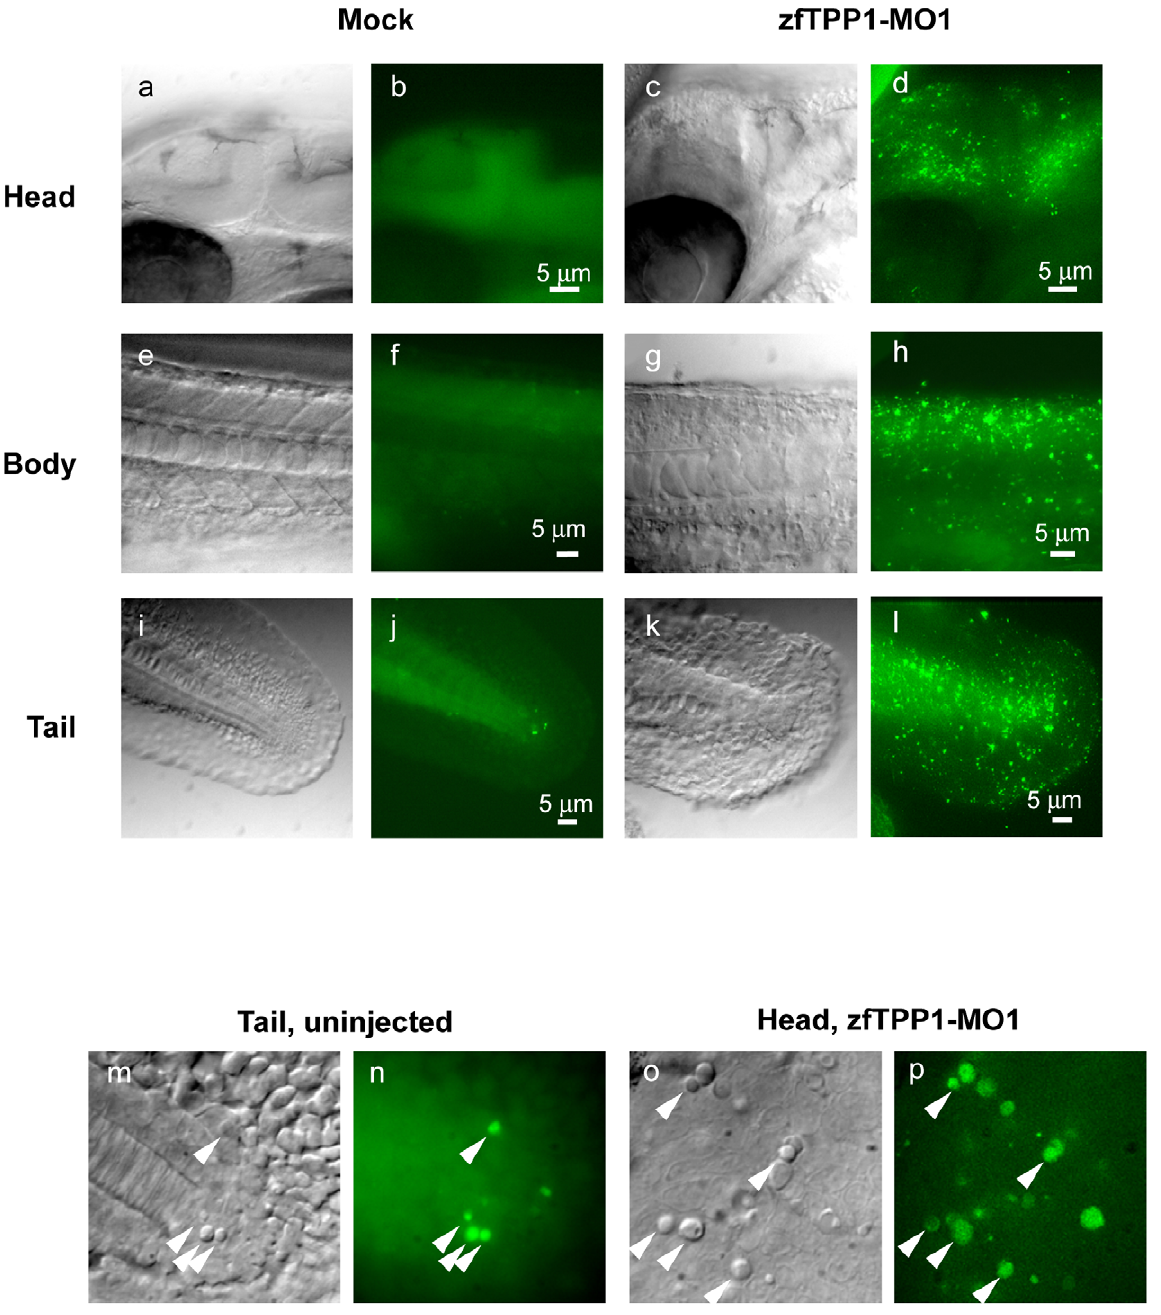
Figure 8. zfTPP1 knockdown induces apoptosis. Embryos injected with zfTPP1 MO1 were stained with acridine orange and visualized (at 28hpf) under Nomarski DIC and fluorescent microscopes (scale bar, 5 m m). Magnified Nomarski DIC and fluorescent images (28 hpf) of the tail (mock injected) (m, n) and head region (zfTPP1 MO1 injected) (o, p) of zebrafish embryos. Arrowheads indicate button-like structures.